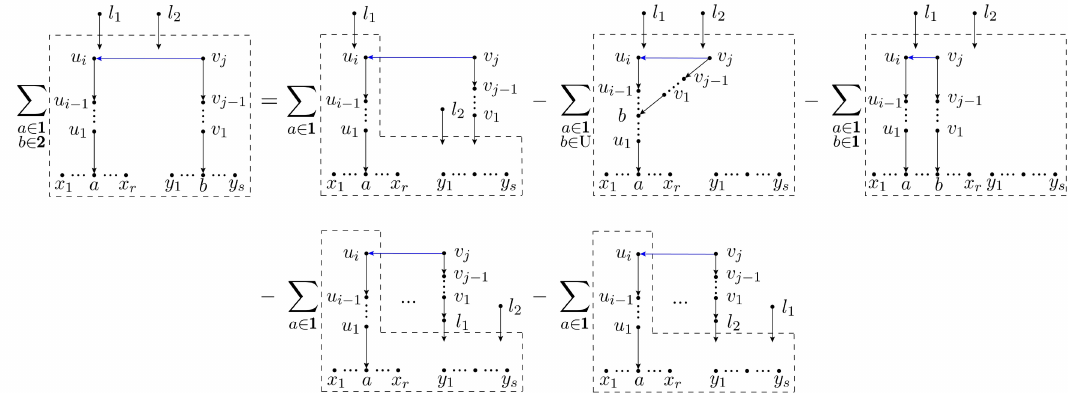
Figure 5 . Transformation-2 of spanning forests with two gravitons l 1 and l 2 outside the boxed region.